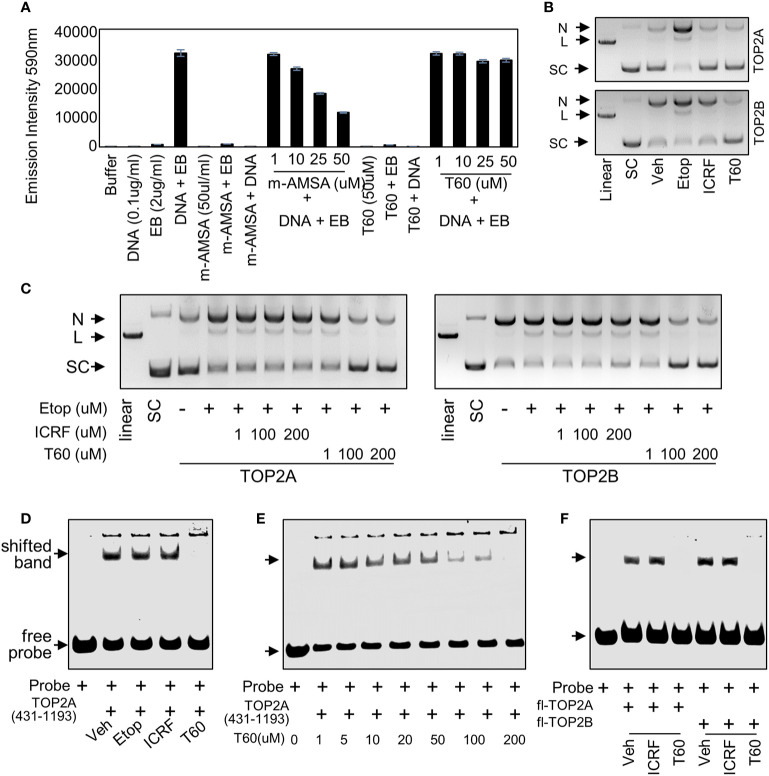
T60 is a catalytic TOP2 inhibitor (A) In ethidium bromide displacement assays, 100 µg/ml salmon sperm DNA was mixed with or without 2 µg/ml ethidium bromide together with the indicated chemicals. Reactions were subjected to fluorescence emission of 590 nm and excitation of 535 nm. Obtained signals were detected by using the Multimode Microplate Reader (Infinite F500). (B) DNA cleavage assays were performed using human TOP2A or TOP2B incubated with the supercoiled pHOT plasmid in the presence of the vehicle, 200 µM of etoposide, ICRF193, or T60 in a reaction buffer without ATP. (C) DNA cleavage assays were performed using full-length human TOP2A and TOP2B incubated with the supercoiled pHOT plasmid in the presence of 200 µM of etoposide plus 1, 100, and 200 µM of ICRF193 or T60. Reactions from (B, C) were separated on a DNA gel with ethidium bromide. (D, E) EMSA was performed by incubating 30 µM of the purified human TOP2A(431-1193) with 300nM of IRDay700 labeled 5ZRF DNA oligo. Vehicle or 200 µM of etoposide, ICRF193, or T60 was added as shown in (D), or 0–200 µM of T60 was added in the reactions as shown in (E). (F) EMSA was performed by incubating 2 µM of full-length TOP2A or TOP2B with 300 nM of IRDay700 labeled 5ZRF DNA oligo in the presence of vehicle or 200 µM of ICRF193 or T60. All experiments were repeated three times, and one representative image was shown. N, nicked DNA; L, linear DNA; and SC, supercoiled DNA.